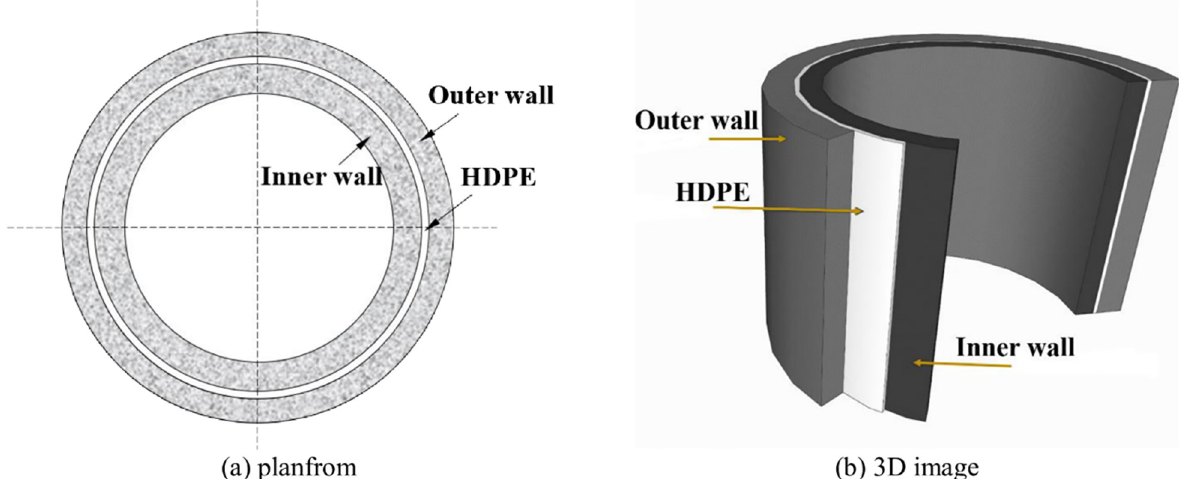
Fig 1. Schematic plot of the composite vertical shaft lining. (a) planfrom. (b) 3D image.